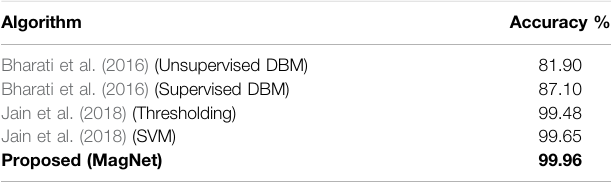
Algorithm Accuracy